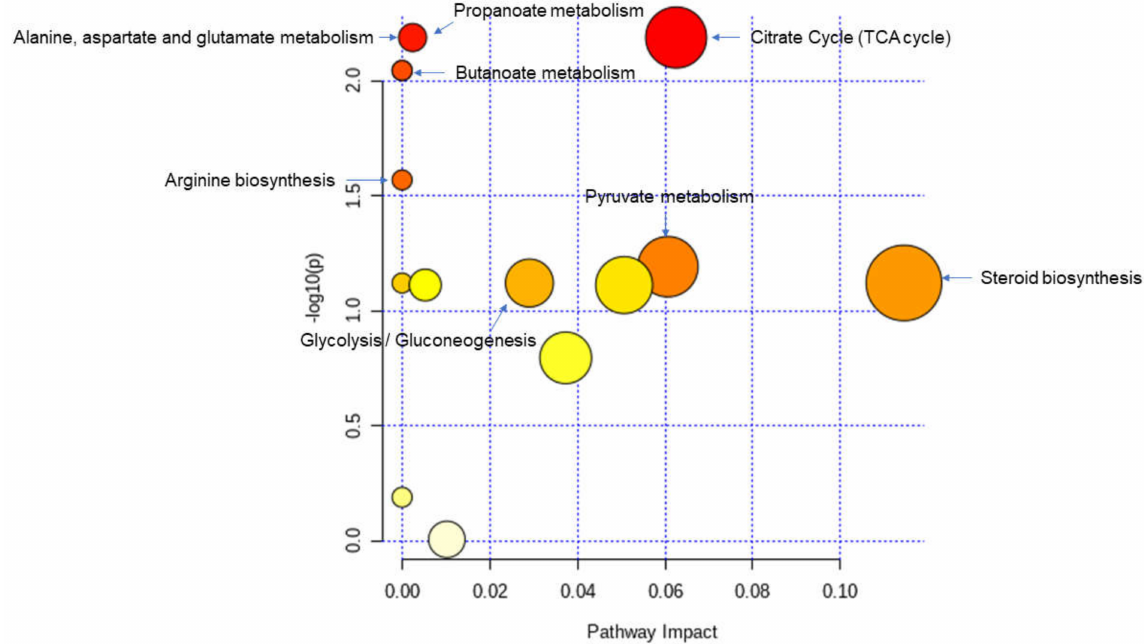
Figure 7. Summary of the pathway analysis with MetPA where all the metabolites were considered. The area of the bubbles is proportional to the effect of transplantation on each pathway, with the color denoting the significance, from highest in red to lowest in